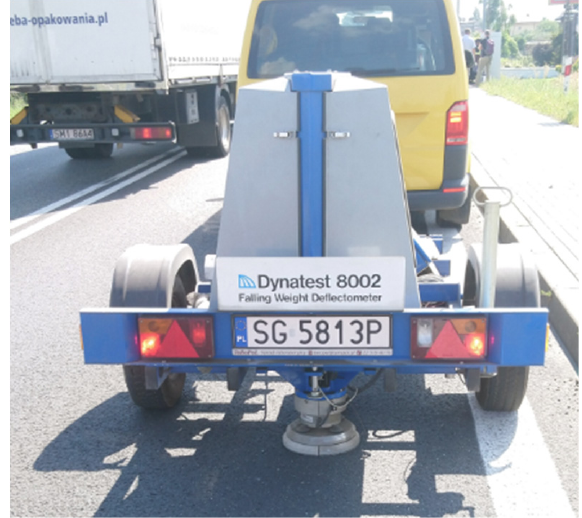
Figure 2. Pavement testing.